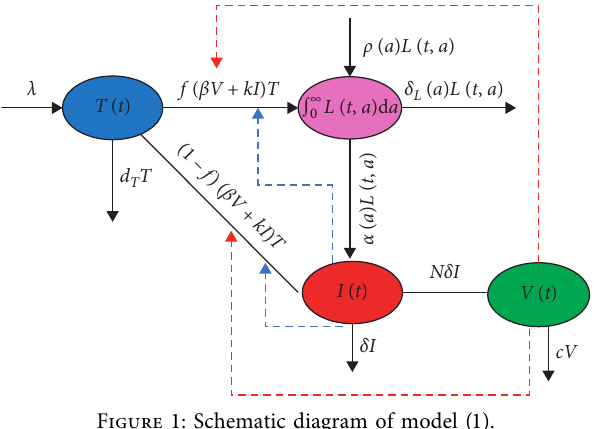
Figure 1: Schematic diagram of model